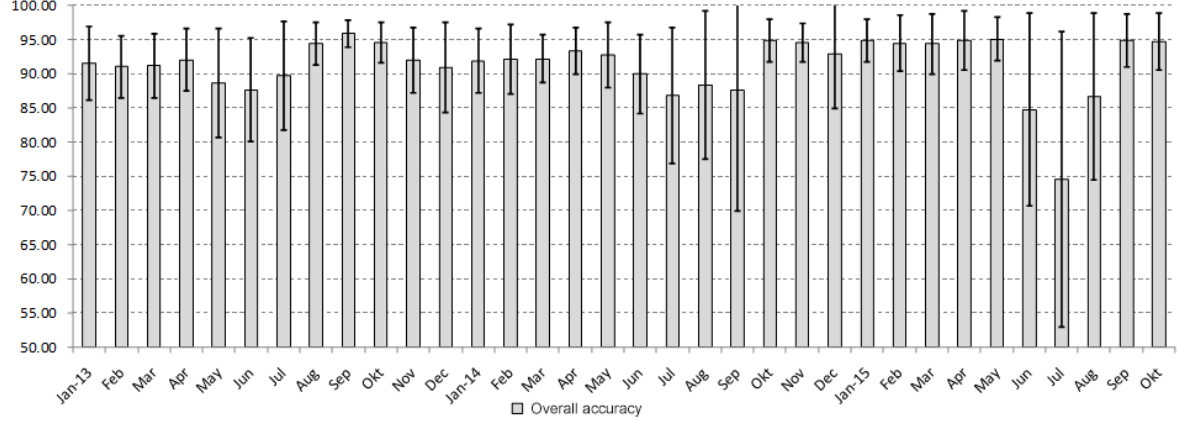
Figure 7. Monthly accuracy and standard deviation of SVM classification of RS2 images assuming that MET Norway operational ice charts are